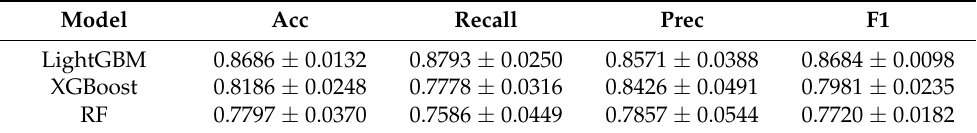
Table 2. Performance of the ensemble learning models in the task of predicting food allergens. Model Acc Recall